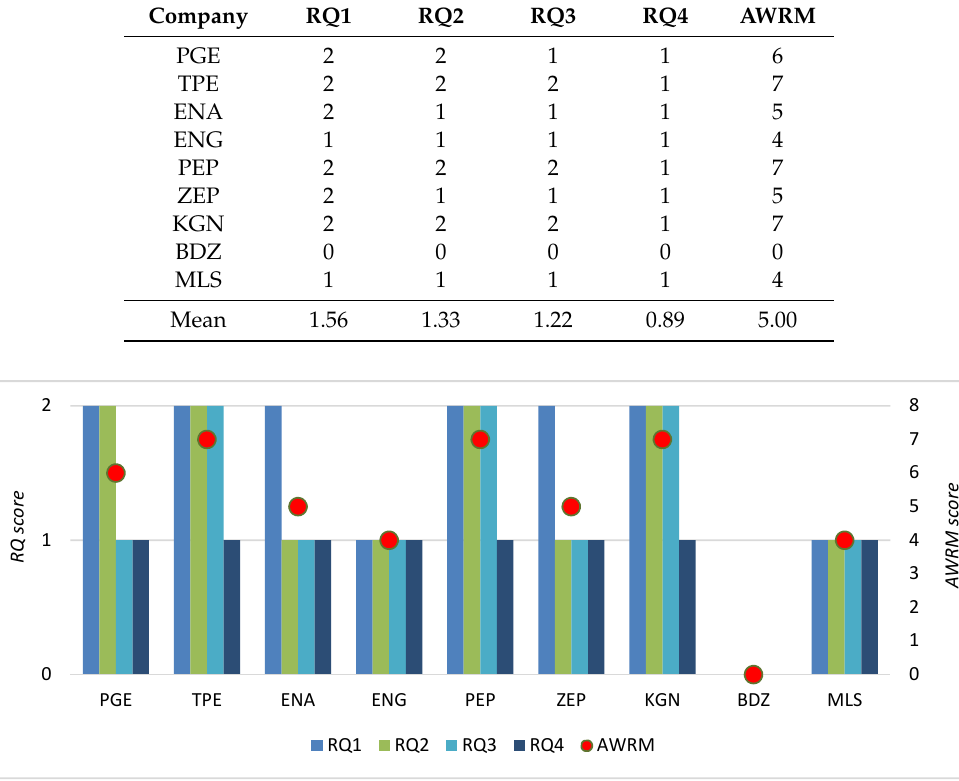
Figure 6. The visualization of the results of textual content analysis.